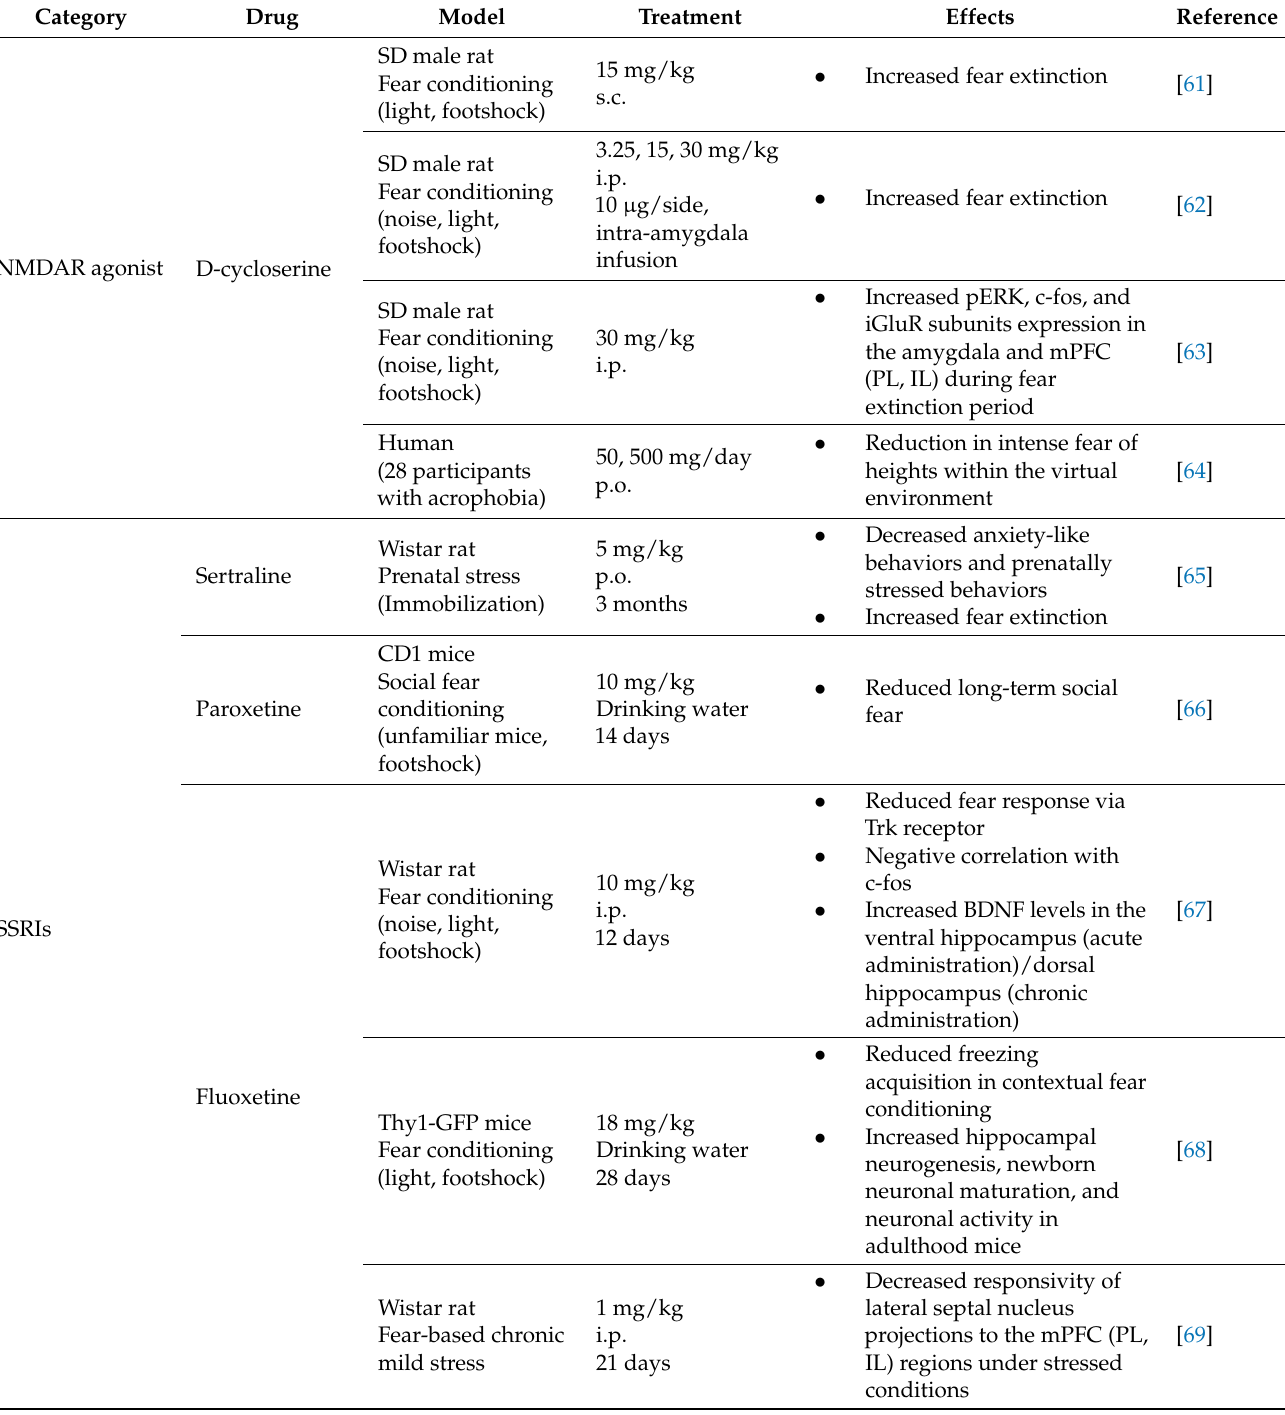
Table 1. Summary of therapeutic interventions modulating proneurogenic efficacy and neural circuits for fear-based